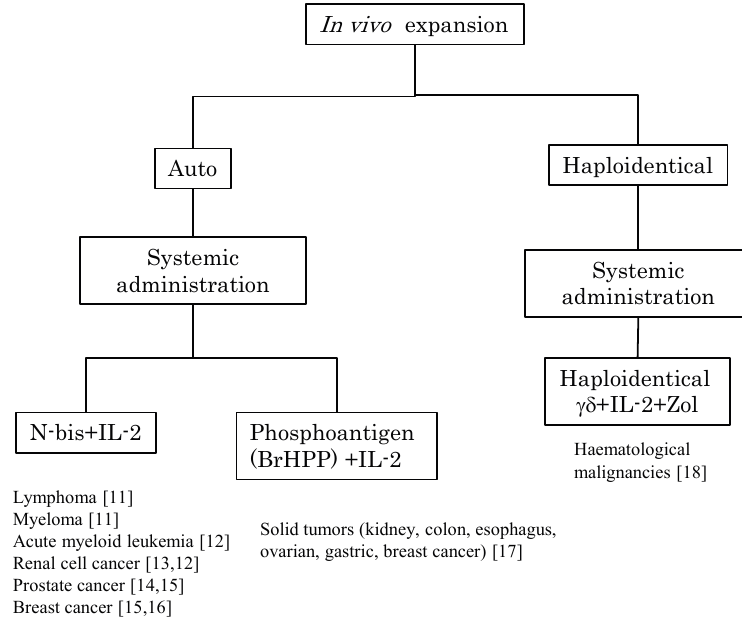
Figure 1. Peripheral blood V γ 9V δ 2 T cells can be stimulated by the systemic administration of phosphoantigen or N-bis and expanded by IL-2 for immunotherapy. The in vivo expansion of V γ 9V δ 2 T cells is divided into two strategies based on the cell origin, namely, autologous V γ 9V δ 2 T cells and haploidentical V γ 9V δ 2 T cells (the latter cells of which are derived from peripheral blood mononuclear cells of half-matched family donors). The stimulators were N-bis or phosphoantigen and all regimens involved the systemic administration of exogenous IL-2. Target tumor types and references [11–18] are